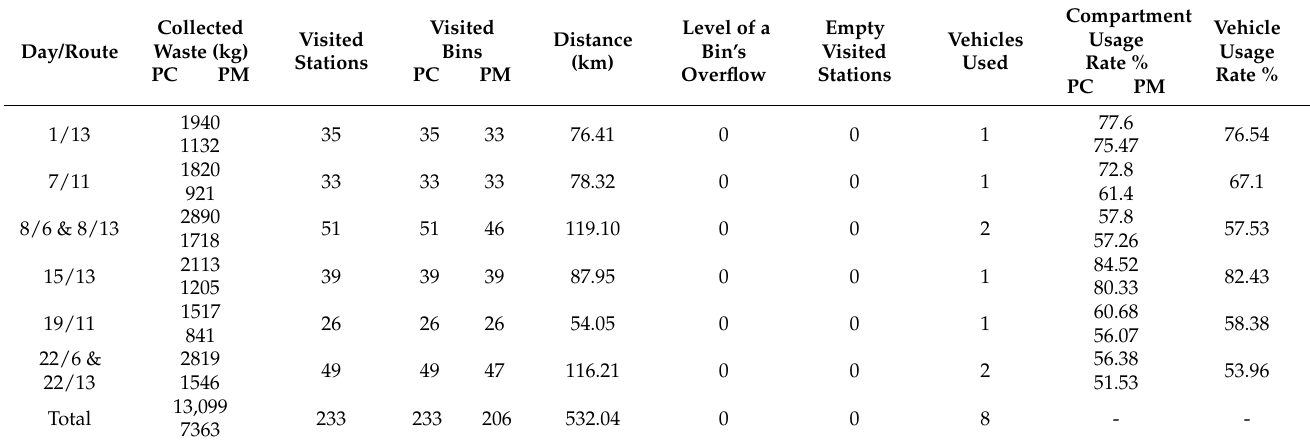
Table 10. Solutions obtained through the hybrid Genetic